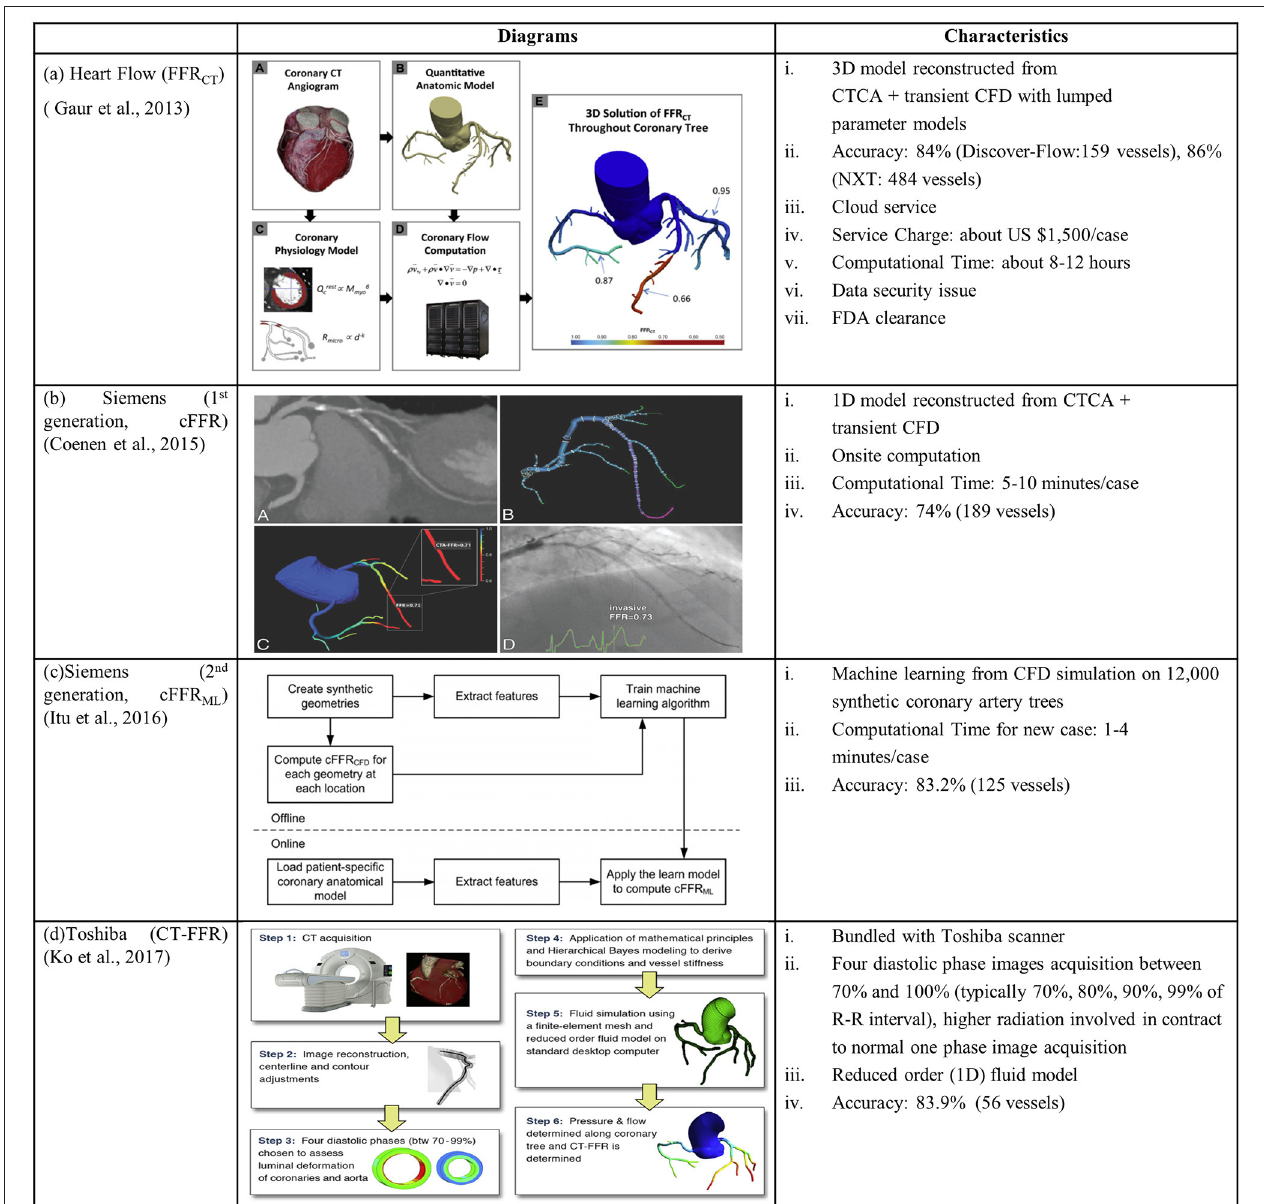
FIGURE 3 | Diagrams and characteristics for calculating non-invasive FFR through combining CTCA with CFD by the companies of (A) Heart Flow: FFR CT (Gaur et al., 2013); (B) Siemens (1st generation: cFFR) (Coenen et al., 2015); (C) Siemens (2nd generation: cFFR ML ) (Itu et al., 2016); and (D) Toshiba: CT-FFR (Ko et al., 2017).